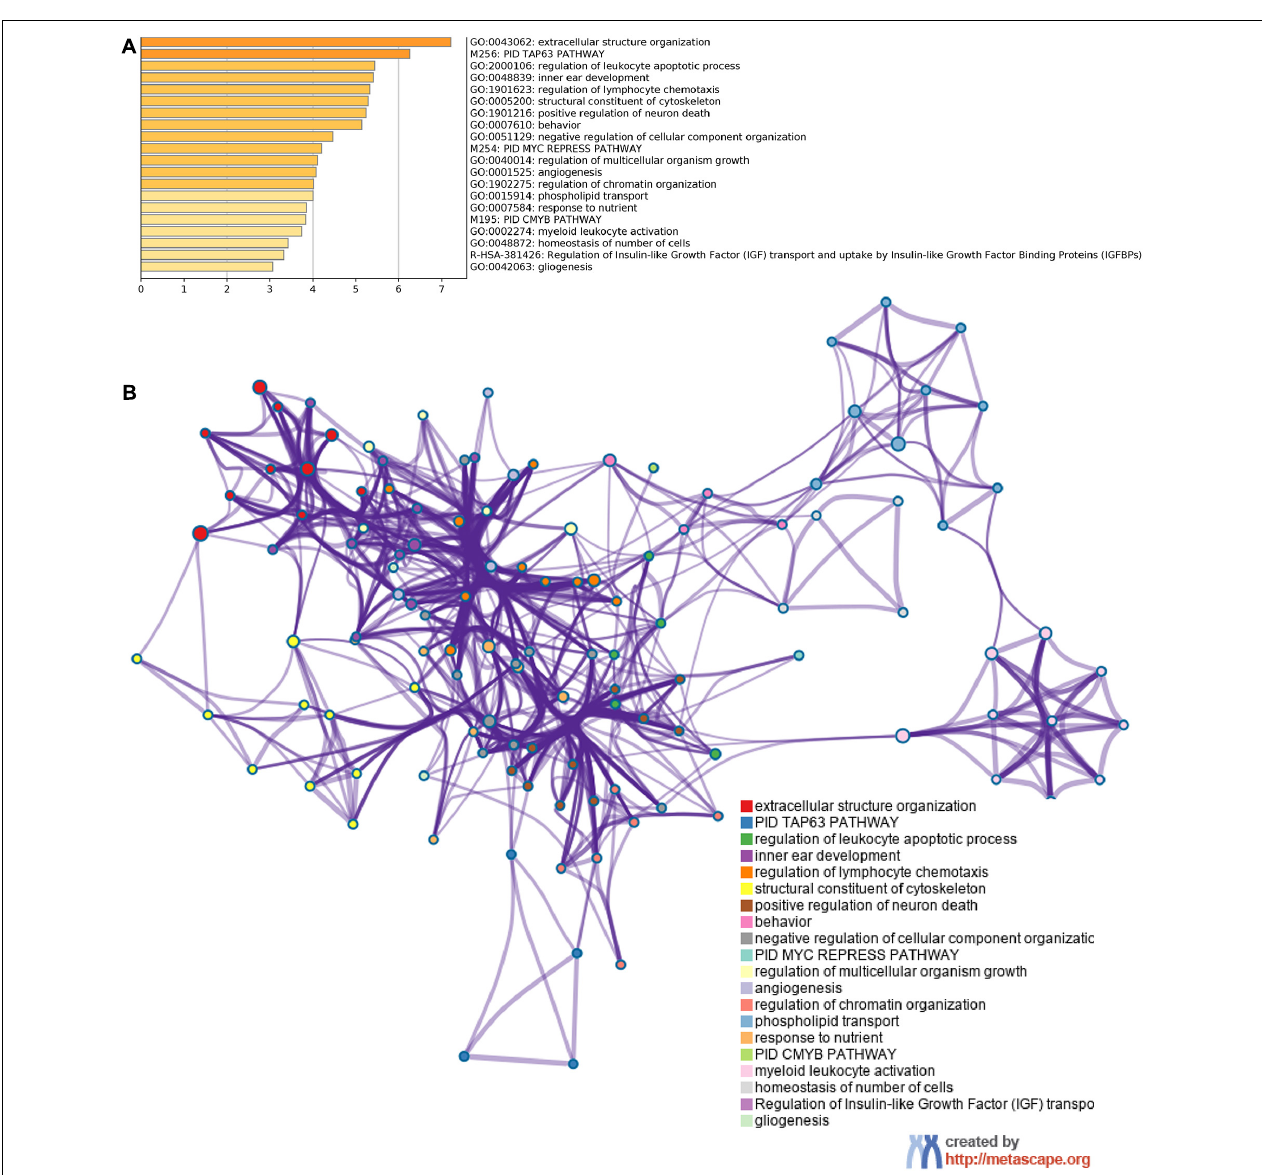
FIGURE 4 | Function enrichment analysis of 67 shared mRNAs. (A) The bar graph of top clusters with their representative enriched terms and (B) a network of enriched terms, colored by cluster-ID, where nodes that share the same cluster-ID are typically close to each